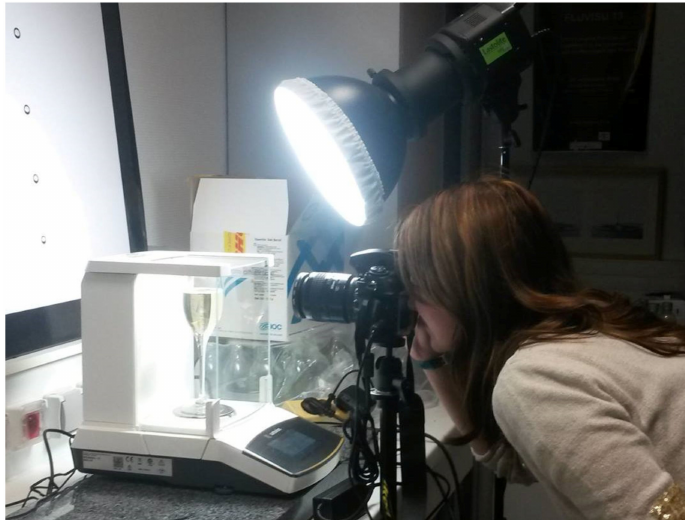
Figure 7. Experimental setup used to monitor simultaneously fluxes of gaseous CO 2 and foaming properties, under standard tasting